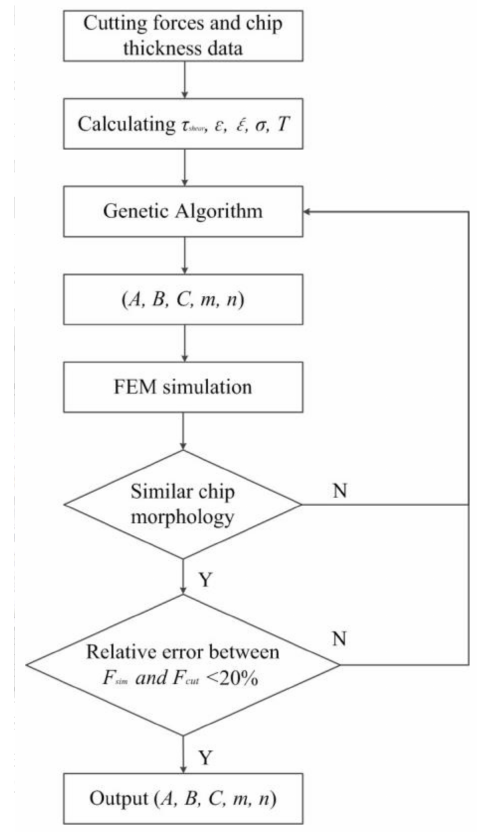
Figure 4. Flowchart of defining the material constitutive